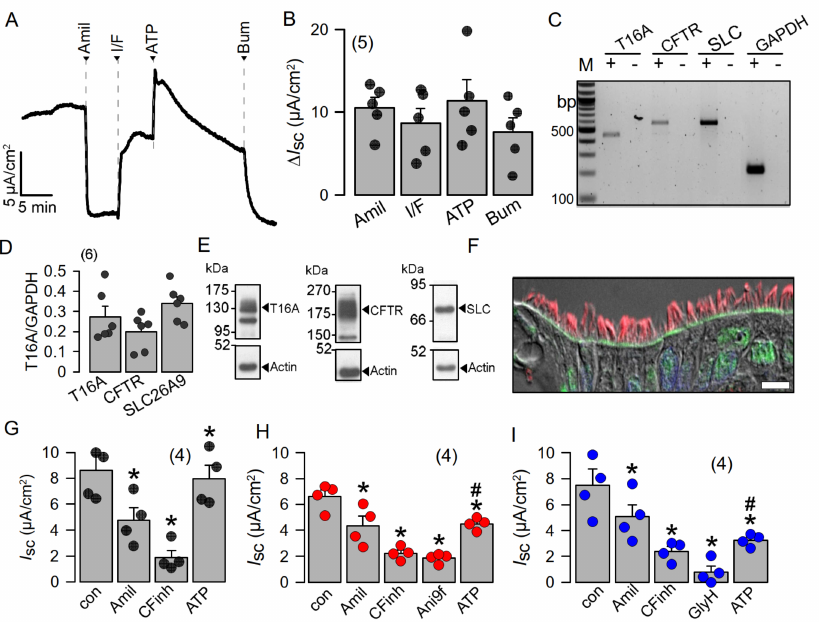
Figure 5. Highly differentiated BCi-NS1 human airway epithelial cells express SLC26A9 in the apical membrane. ( A , B ) Using chamber short-circuit current (Isc) recording from highly differentiated BCi- NS1 human airway epithelial cells. Isc is inhibited by amiloride (10 µ M), indicating the expression of epithelial Na + channels (ENaC). IBMX (100 µ M) and forskolin (2 µ M) activate a non-transient CFTR-dependent Isc, which is inhibited by basolateral bumetanide (20 µ M). Luminal ATP (100 µ M) activates a transient Isc. ( C , D ) Expression of the major Cl − secretory proteins, TMEM16A (T16A), CFTR and SLC26A9 (SLC), as detected by RT-PCR. ( E ) Expression of TMEM16A, CFTR and SLC26A9 detected by Western blotting. Blots were performed in duplicate. ( F ) Immunocytochemistry of SLC26A9 (green) and acetylated tubulin (red) in ciliated cells of highly differentiated BCi-NS1 cells grown on permeable supports. Bar = 10 µ m. Nuclei were stained by DAPI. ( G – I ) Summaries of basal short-circuit currents in BCi-NS1 monolayers, indicating CFTR activity contributing to basal Isc, as detected by CFTRinh172 (CFinh; 10 µ M). The TMEM16A-inhibitor Ani9f (10 µ M) largely reduces ATP-activated TMEM16A-dependent Cl − secretion. The inhibitor GlyH101 (Gly; 10 µ M) further inhibits basal Isc after inhibition of CFTR by CFTRinh172. Mean ± SEM (number of tissues). * Significant effects by compounds ( p < 0.05; paired t -test). # Significant difference compared to G ( p < 0.05; unpaired t